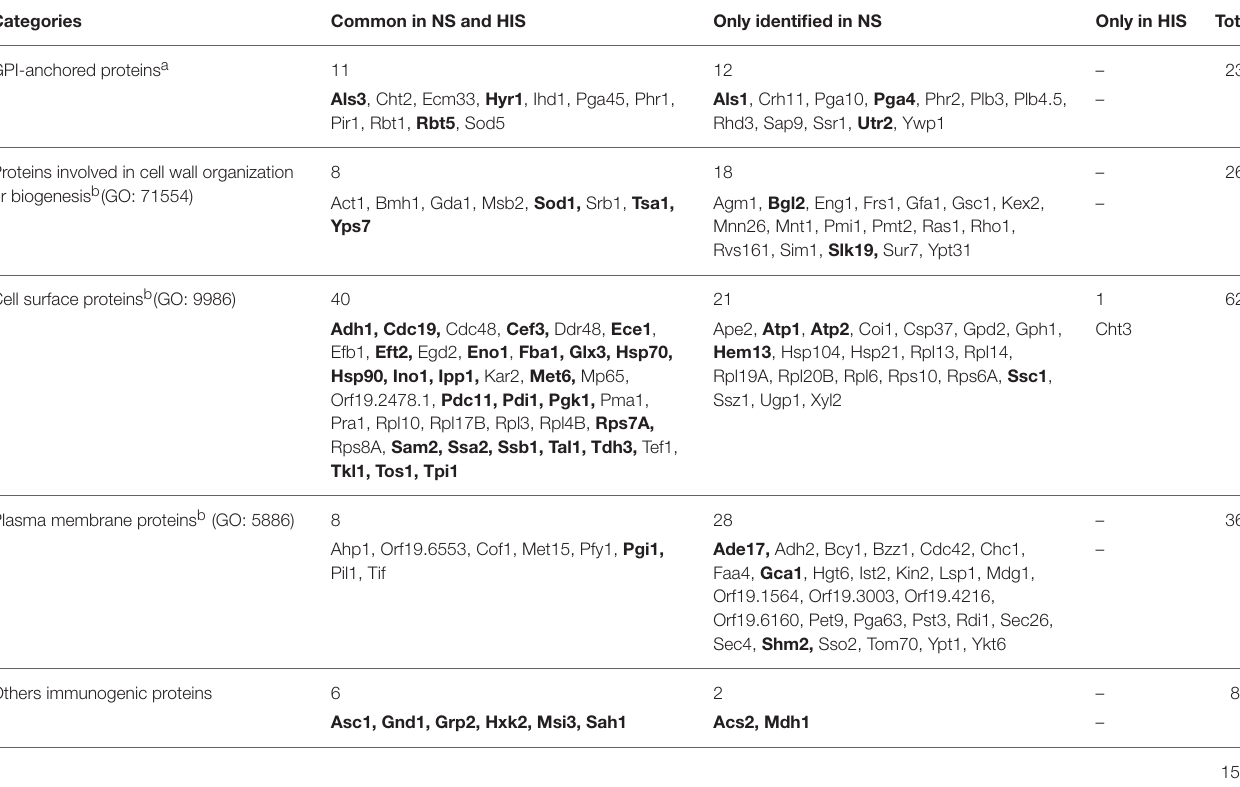
TABLE 1 | Selected C. albicans proteins identified after incubation with 10% NS or HIS related with cell surface and immunogenicity. Categories Common in NS and HIS Only identified in NS Only in